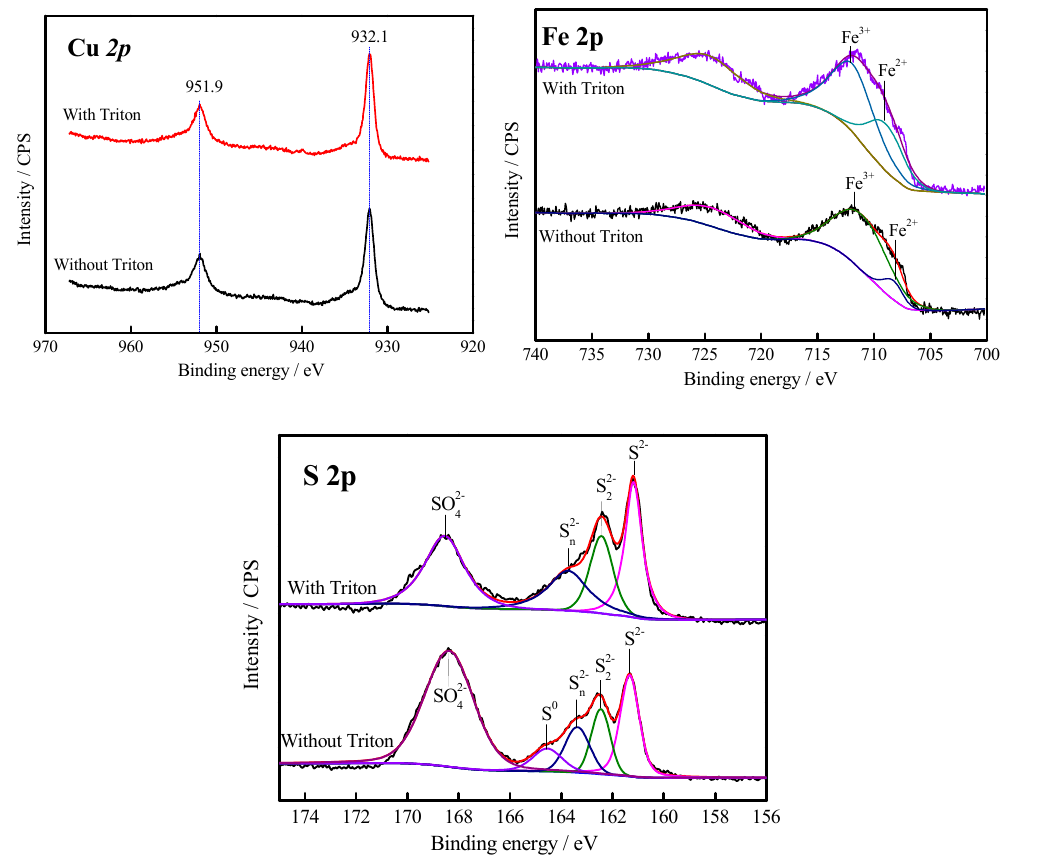
Figure 8. Cu 2p , Fe 2p and S 2p XPS spectra of chalcopyrite bioleached without and with Triton X-100. (Chalcopyrite 1% ( w / v ), Triton X-100 30 mg · L − 1 , initial cell density 2 × 10 7 cells · mL − 1 , initial Fe 2+ 0 g · L − 1 , initial pH 2.0, rotational speed 160 rpm, temperature 30 ◦ C, and leaching for 24